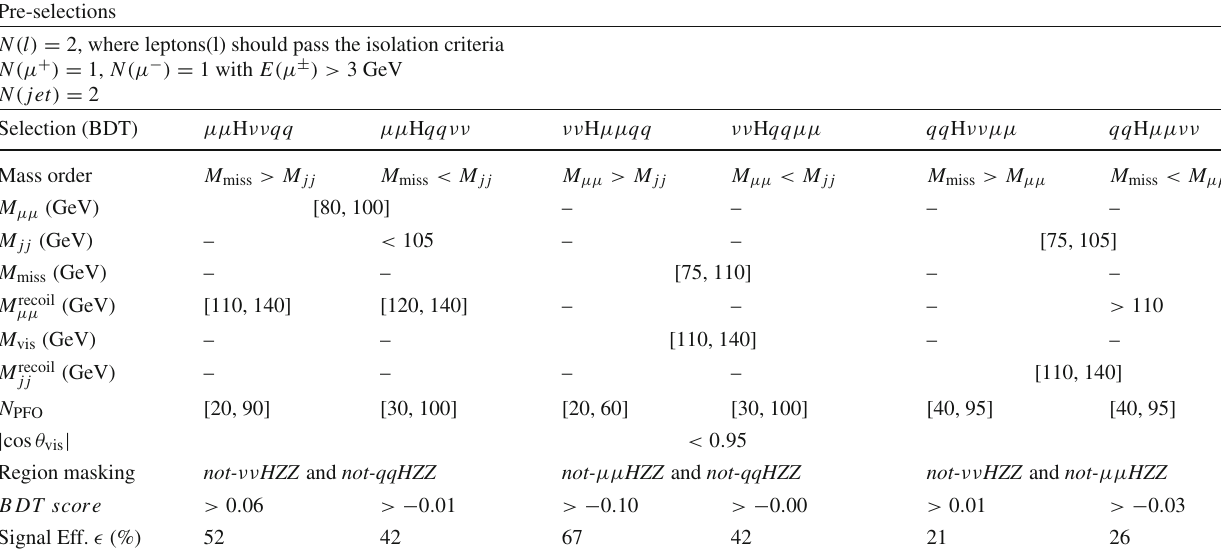
Fig. 2 BDT score distributions for two of most sensitive categories: a μμ H νν qq mva category and b νν H μμ qq mva category. The signal distribution is shown with a red histogram while background contributions, ZH (green), four-fermion (cyan) and two-fermion (yellow), are drawn Table 3 Overview of the requirements applied when selecting events (BDT-based). The last row shows the final selection efficiency for the signal where the dominant and sub-dominant signal processes are